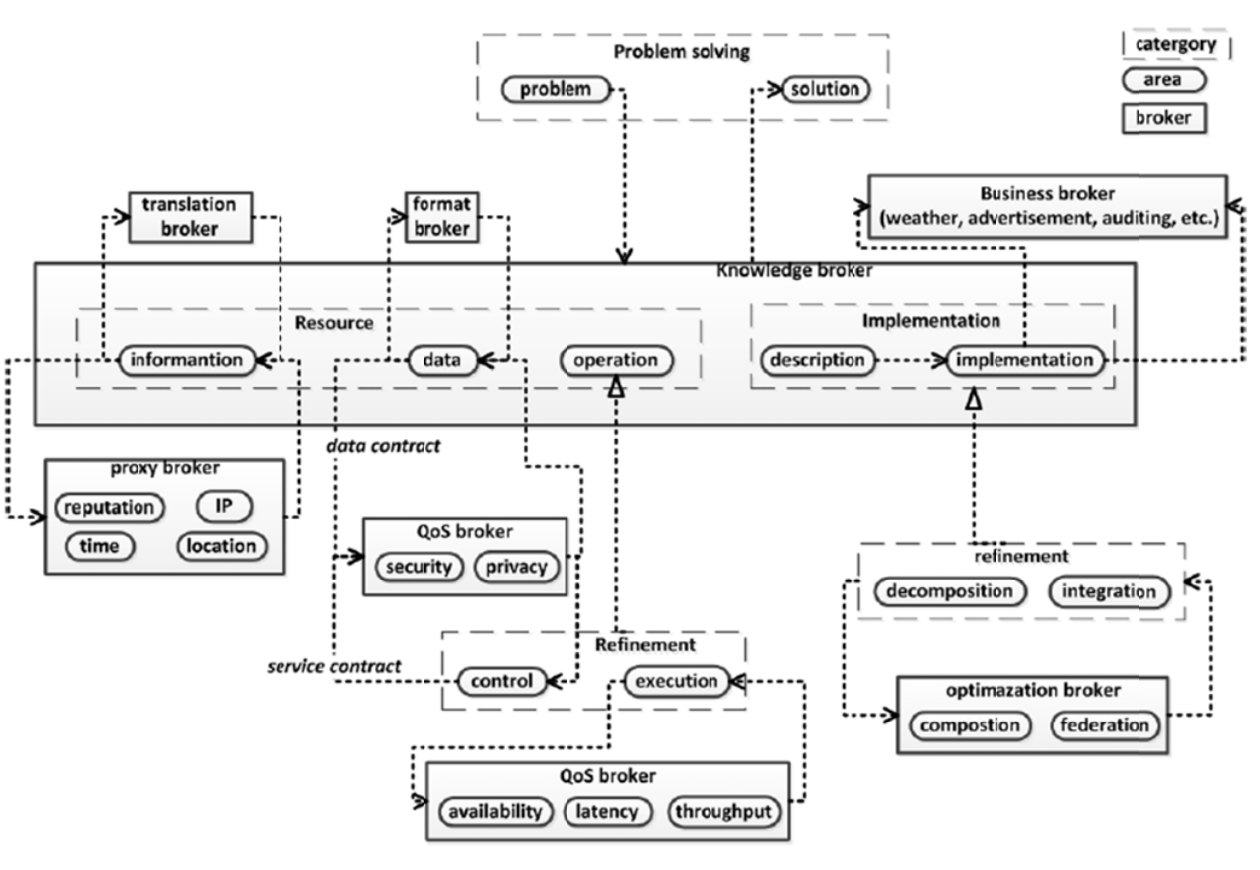
Figuure. 4. Classific